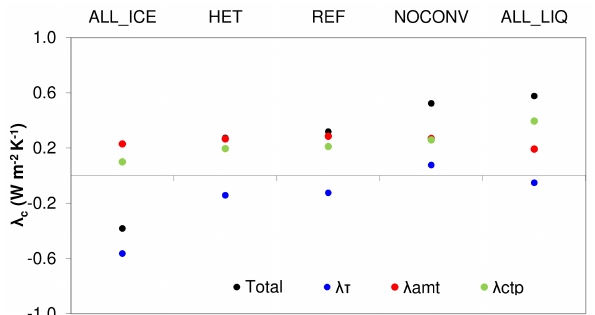
Figure 6. Components of the globally averaged cloud feedback pa- rameter λ c in Wm − 2 K − 1 for the simulations described in Table 1. λ τ accounts for changes in cloud optical depth, λ amt accounts for changes in cloud amount, and λ ctp accounts for changes in cloud- top